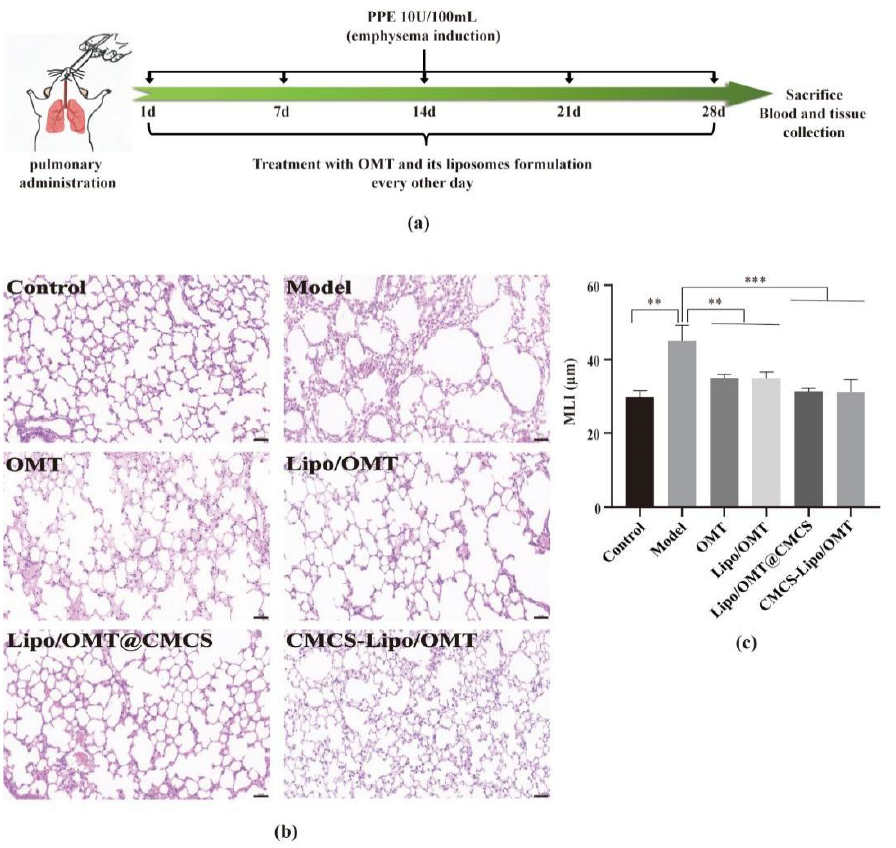
Figure 3. Effect of OMT and its liposomal preparations on the structure of lung tissue in PPE-induced emphysema mice. ( a ) A scheme of experimental protocol for the establishment of an emphysema model and therapeutic regimen. ( b ) Representative histology images of the lung sections from each group, stained with H&E (magnification, ×200; Scale bar = 50 μ m). ( c ) Quantitation of mean linear intercept (MLI) of lung tissue. All data are expressed as mean ± SD ( n = 3). ** p < 0.01, *** p < 0.001.